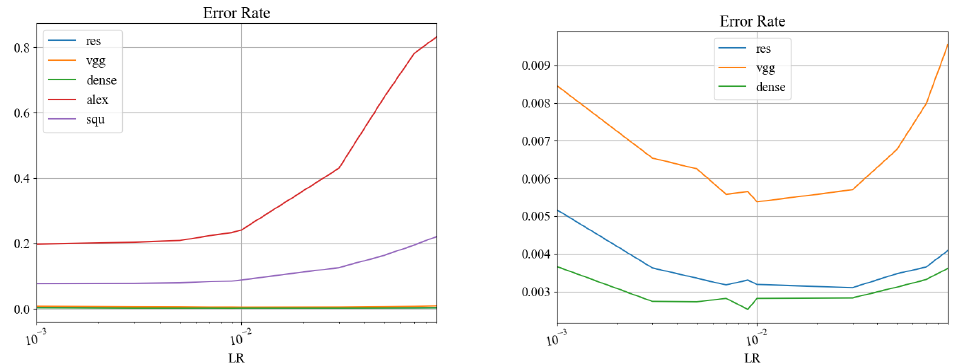
Figure 9. Compared performance of five DL networks for modern kanji classification (ETL dataset subset containing 2136 regular use kanji). Left , error rate (ER) results for all the DL networks considered. Right , details for the three best-performing networks.